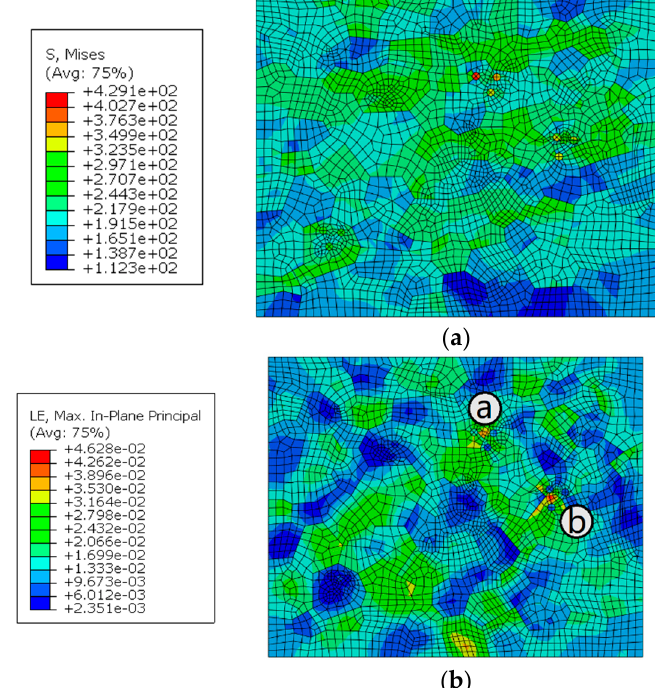
Figure 18. Distribution of ( a ) von Mises equivalent stress, MPa, and ( b ) principal strain in the WNZ including the hardening particle cluster.